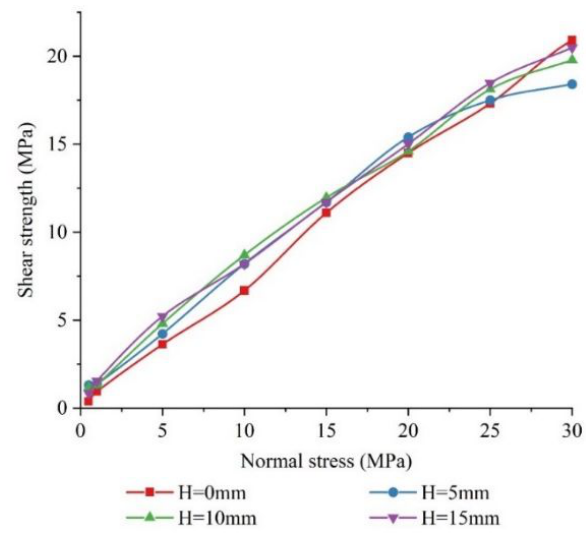
Figure 10: Relationship between shear strength and normal stress under different saw-tooth heights